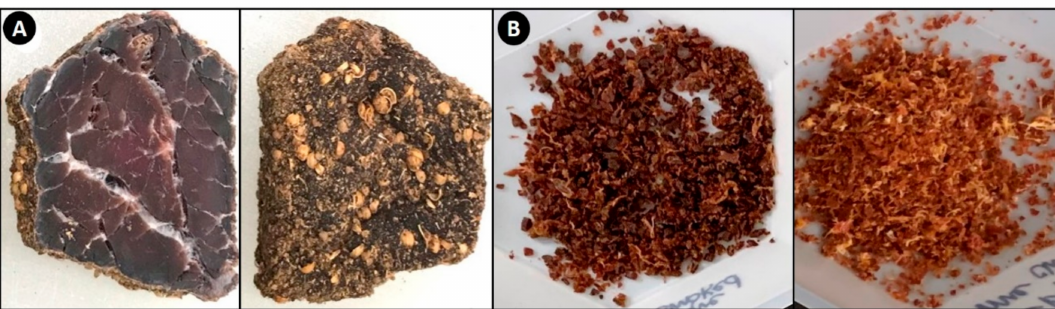
Figure 1. Sampling biltong for salt ion analyses: ( A ) representative in-house manufactured biltong after 8 days of drying showing the inside of dried beef muscle tissue (left) and retention of surface seasoning (right); ( B ) finely ground biltong samples to be mixed in water for ion